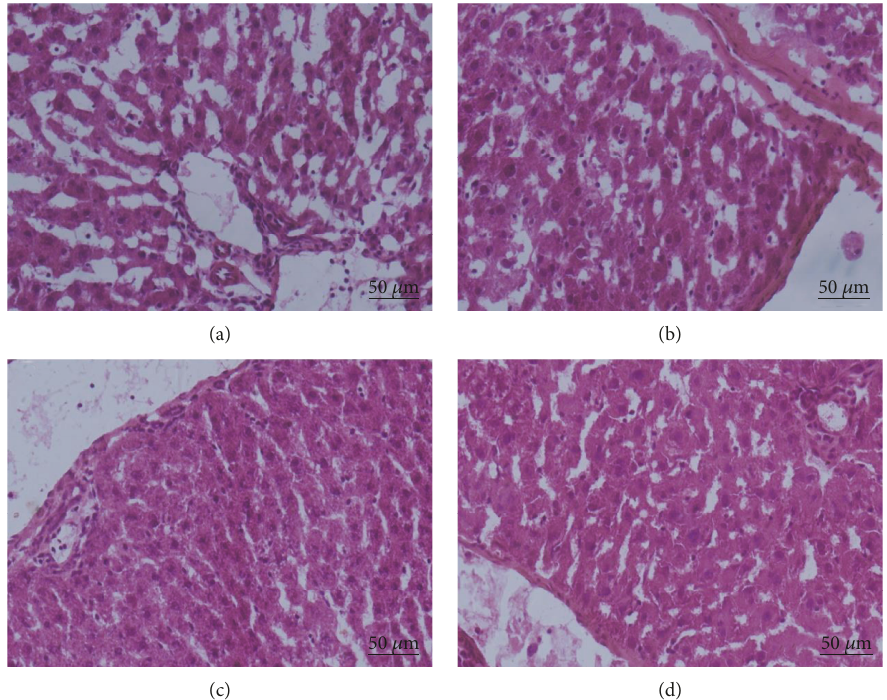
Figure 4: Hematoxylin and Eosin staining of liver sections from DNM-injured rats that received cell transplant. (a) DNM-injured rats did not receive cell transplant showed hemorrhagic necrotic and disruption of tissue architecture. (b) DNM-injured rat received rBM-MSC transplant showed some changes of necrosis areas and the tissue architecture. (c) DNM-injured rat received rBM-MSC-DSC transplant showed signi fi cant changes of necrosis areas and the tissue architecture. (d) Normal liver. Original magni fi cation, 200x.